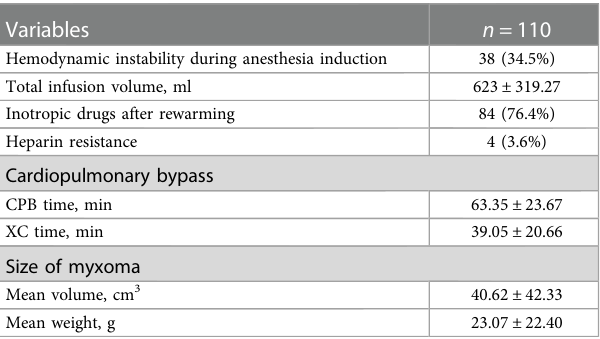
( Figure 2A ). More patients in group O had hemodynamic instability (47.9% vs. 24.2%, p = 0.009) compared to group N ( Figure 2B ).